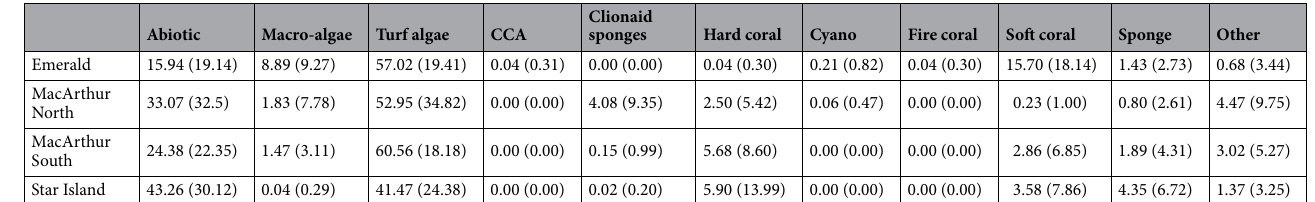
Table 3. Percent cover of the benthos at a natural coral reef (Emerald) and three inshore urban sites (MacArthur North, MacArthur South, and Star Island). Abiotic is inclusive of bare hard bottom, sediment, and trash. CCA is crustose coralline algae, Cyano. is cyanobacteria. Standard deviations are in